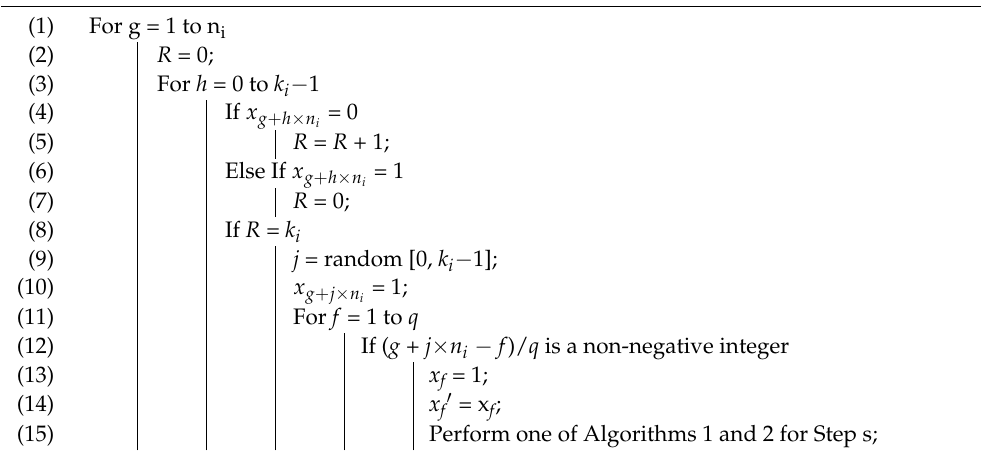
Algorithm 3: Individual modification for the case with d i = 1 and m i + 1 ≥ k